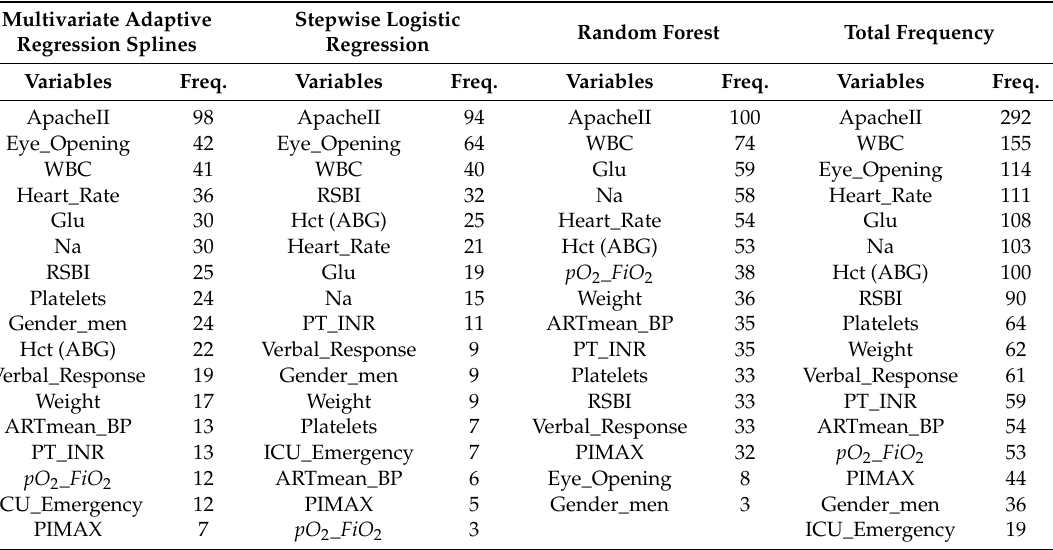
Table 2. The results of variable selection methods.